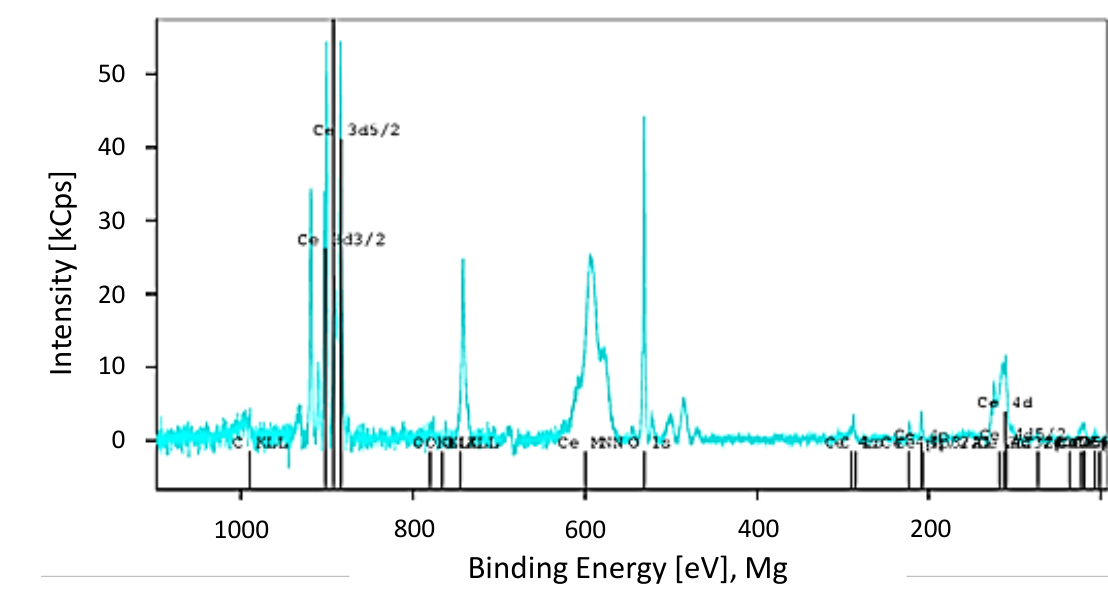
Figure 3. XPS spectra of Ce from CeO 2 -NPs.